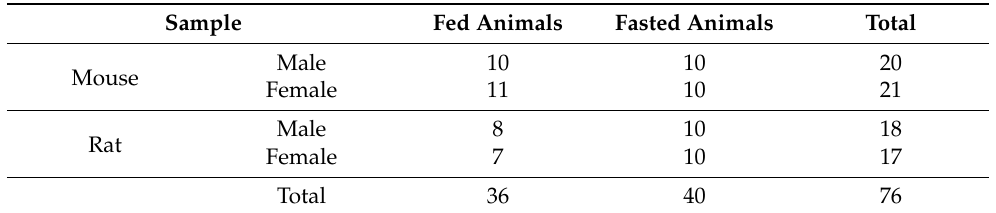
Table 1. Number of animals included in serum lactate dehydrogenase and alkaline phosphatase activity analysis.